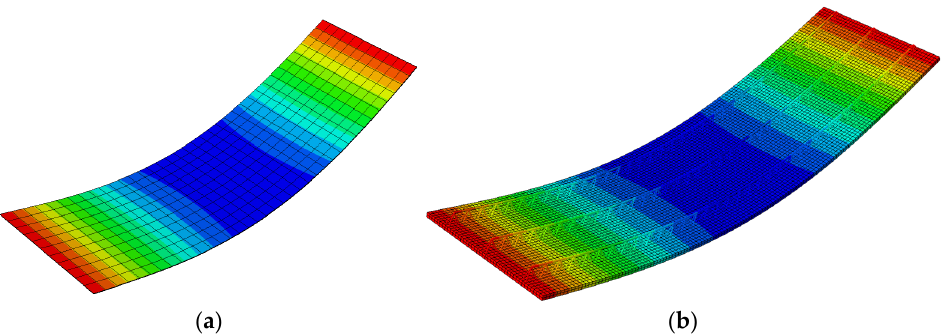
Table 5. The deflection at the mid-span computed using the full 3D model (Type-D) and three sim- plified shell models (based on RVE-1 homogenization FE model).